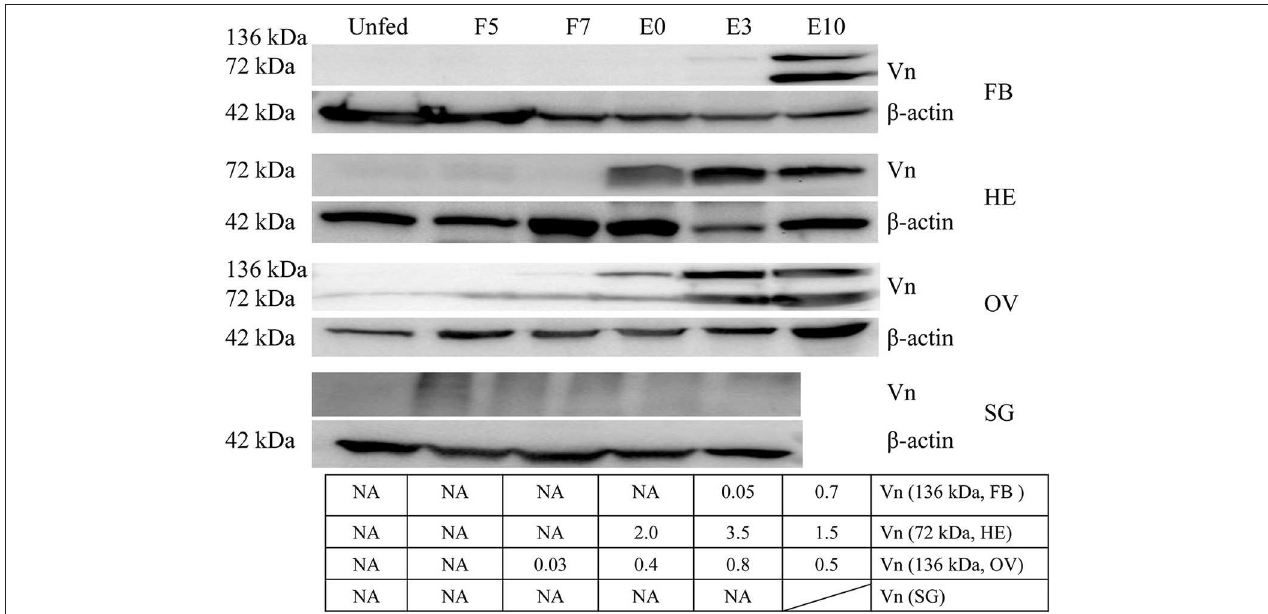
FIGURE 2 | Vitellin expression is induced by blood feeding. Except for salivary gland, vitellin protein was expressed highly in fat body, hemolymph, ovary at different engorgement statuses by Western blot. The intensities of vitellin protein bands (136 and 72 kDa) were determined, normalized to β -actin. Vn, Vitellin; FB, fat body; HE, hemolymph; OV, ovary; SG, salivary gland; UF, unfed; F5, at day 5 for blood feeding; F7, at day 7 for blood feeding; E0, on the day of engorgement; E3, at 3 days post-engorgement; E10, at day 10 after engorgement.